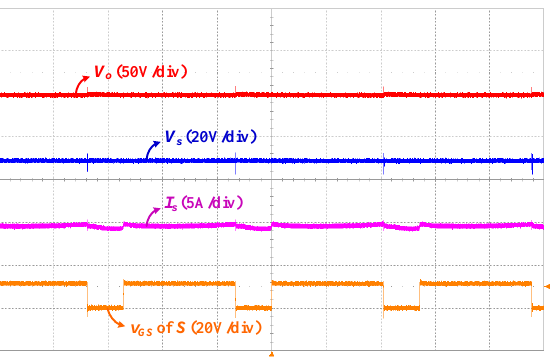
Figure 11. The output voltage waveform of the proposed converter under full load condition (50 ms/div).